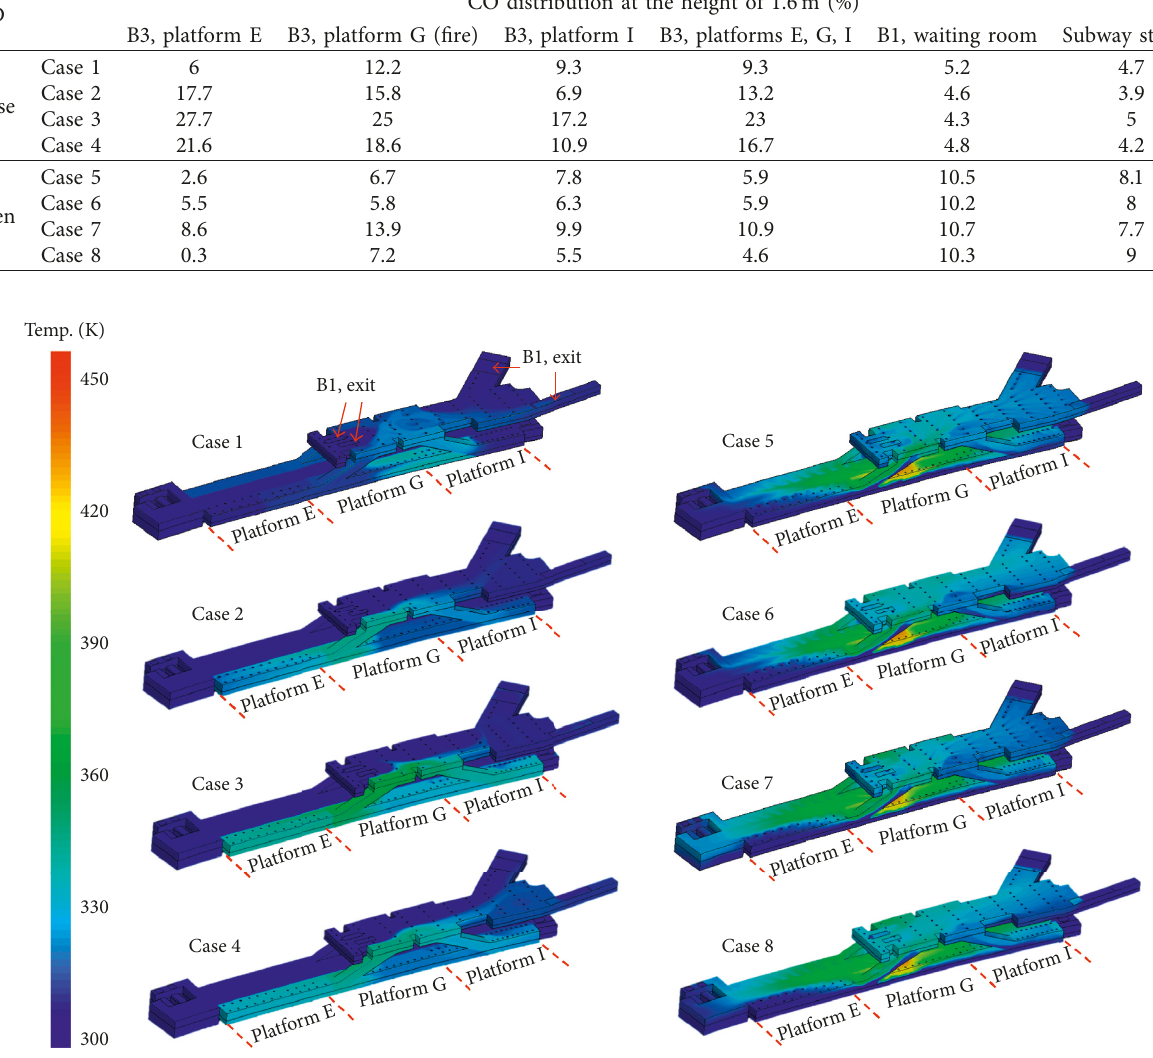
Figure 3: Temperature contours of underground subway